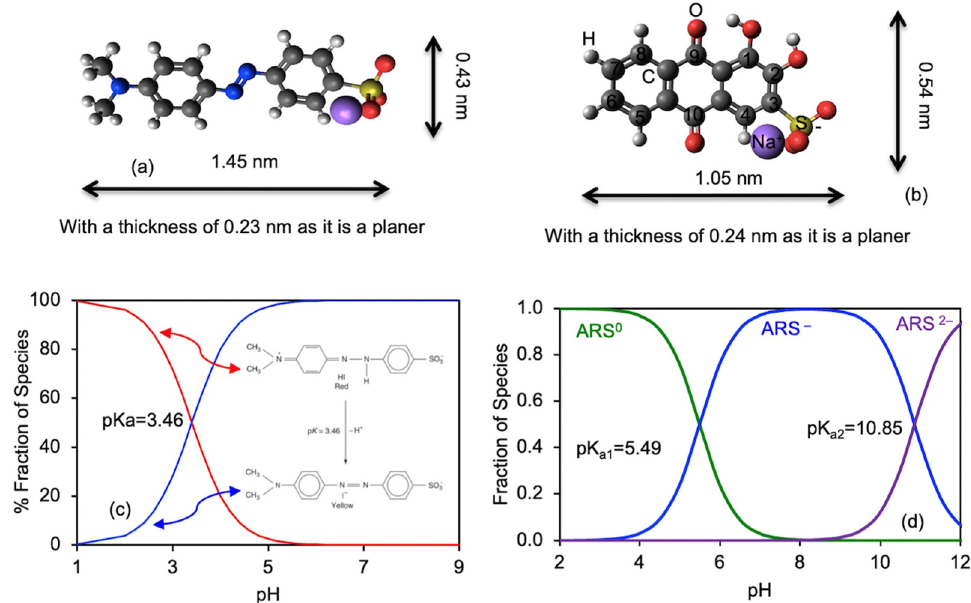
Figure 1. Molecular structure of MO ( a ) and ARS ( b ) and their pH speciation diagrams ( c , d ).